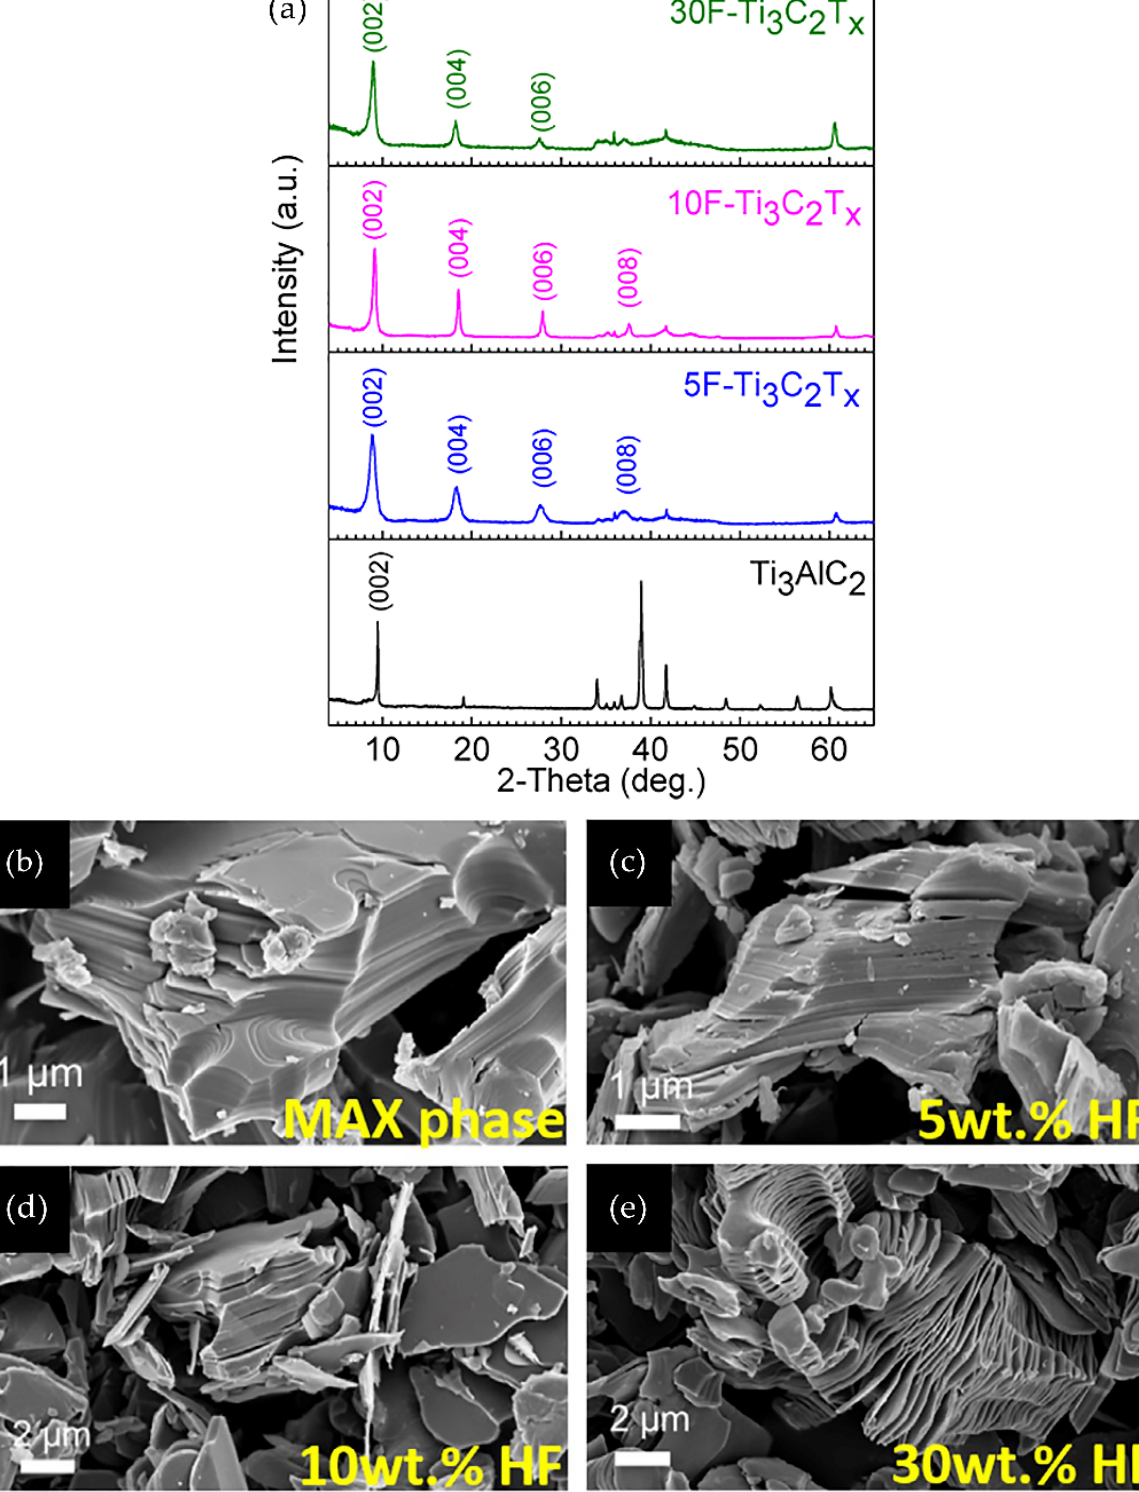
Figure 10. ( a ), X-ray spectra and SEM images of Ti 3 AlC 2 MAX phase ( b ) and Ti 3 C 2 T x MXene powders synthesized using ( c ) 5, ( d ) 10, and ( e ) 30 wt.% HF. Reprinted with permission from [63] 2017 American Chemical Society.